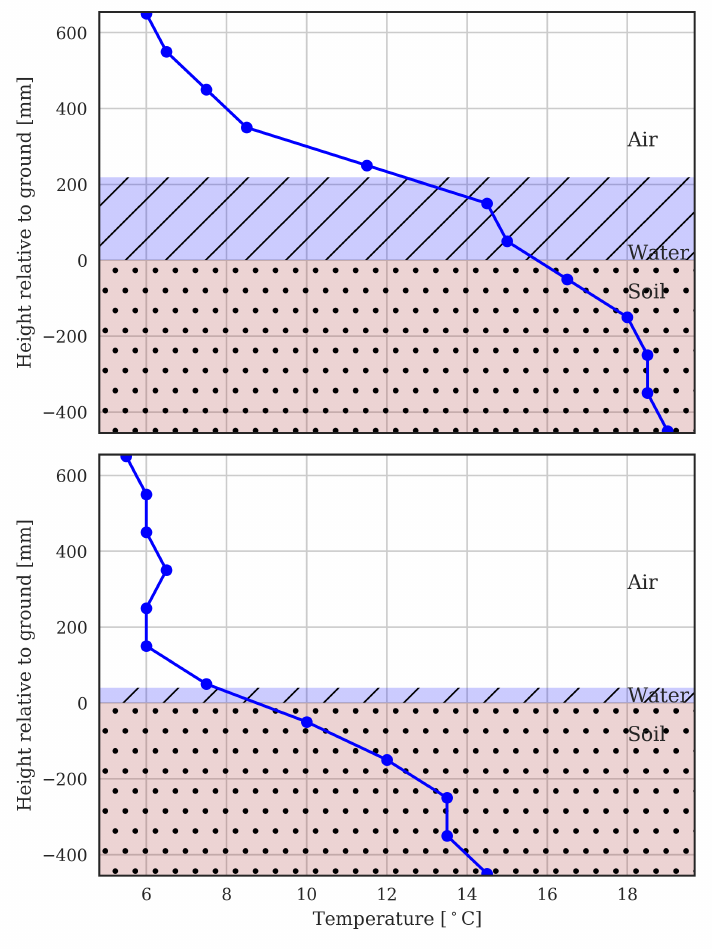
Figure 8. The temperature profile measured by the MCP during cold temperature events (20 February 2017 and 12 April 2017 6AM). The measured water depth is indicated with blue